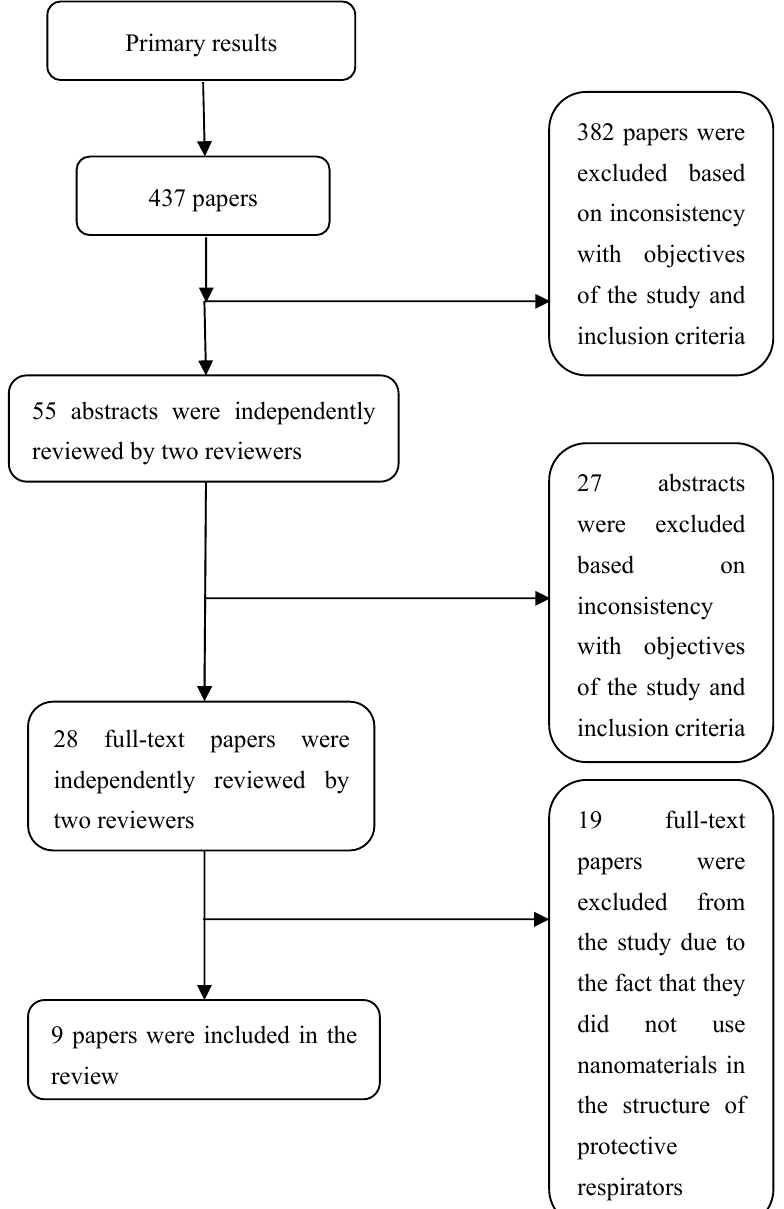
Figure 1. Flowchart showing selecting process.